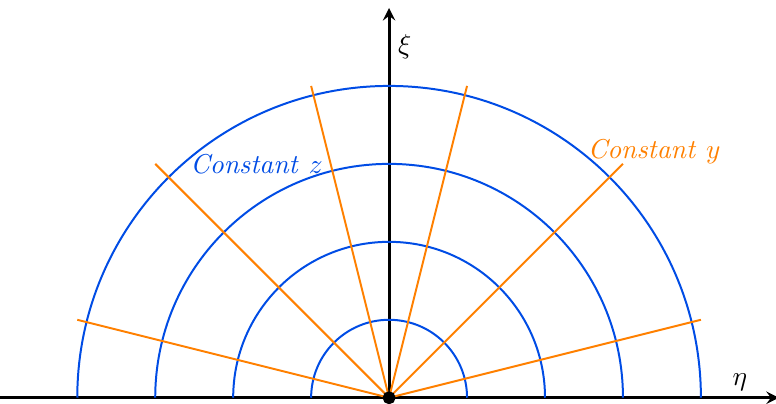
Figure 1 . Foliation of the AdS 3 geometry into AdS 2 slices, where the lines at constant y and z coordinates are depicted. The black dot in the origin is the location of the Janus